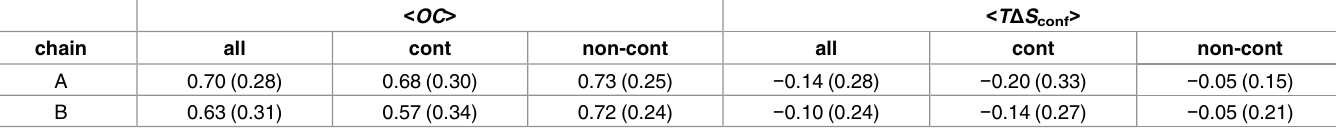
Table 2. Averagehistogram overlap and entropy change in crystal and solution MD for solvent-exposed residues in CVN a .